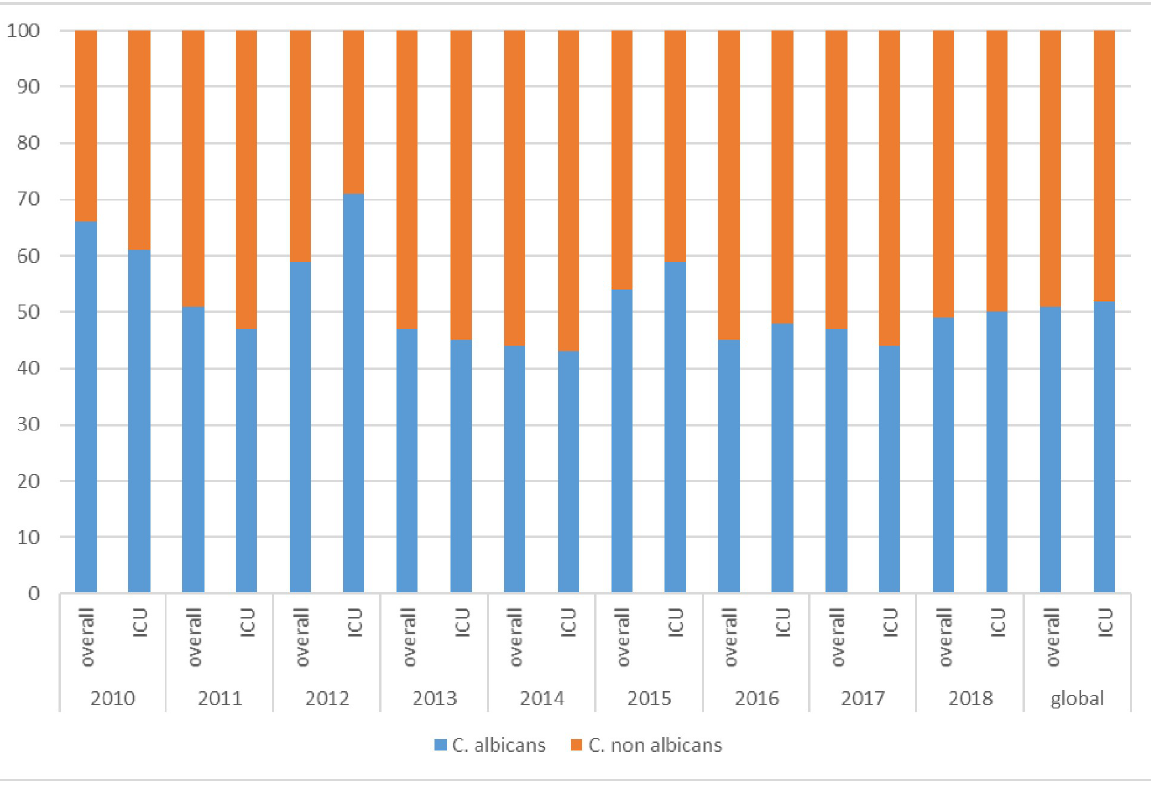
PLOS ONE | https://doi.org/10.1371/journal.pone.0252165 May 26,